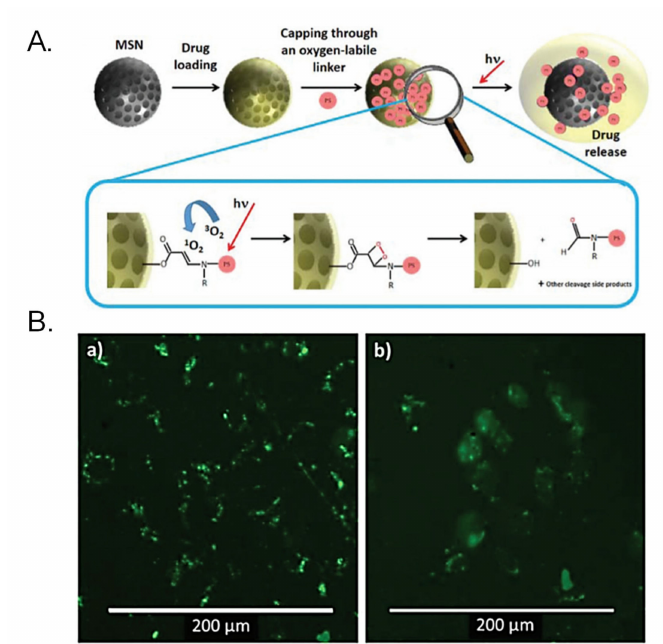
Figure 2. ( A ) Schematic representation of MSNs engineered for achieving endosomal escape through reactive oxygen species (ROS) generation. A visible light-sensitive porphyrin is grafted to the surface through a ROS-responsive linker that is cleaved when upon light irradiation, triggering endosomal escape and drug release. ( B ) Calcein assay for assessing endosomal escape: Calcein is a membrane-impermeable dye that is unable to cross the lipid bilayer of the endo-lysosomes in the dark. When light is applied, ROS generated destabilizes the membrane and calcein di ff uses into the cytoplasm. Reproduced from Ref. [75] with permission from The Royal Society of